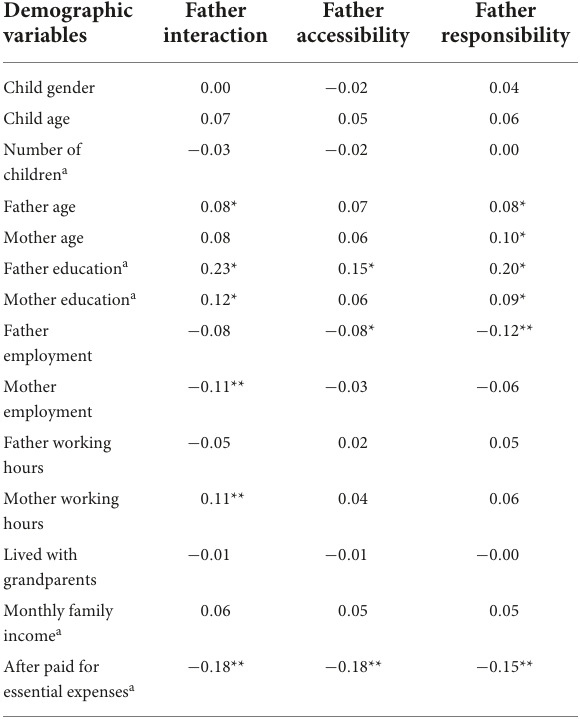
TABLE 1 Correlations of dimensions of father involvement with demographic